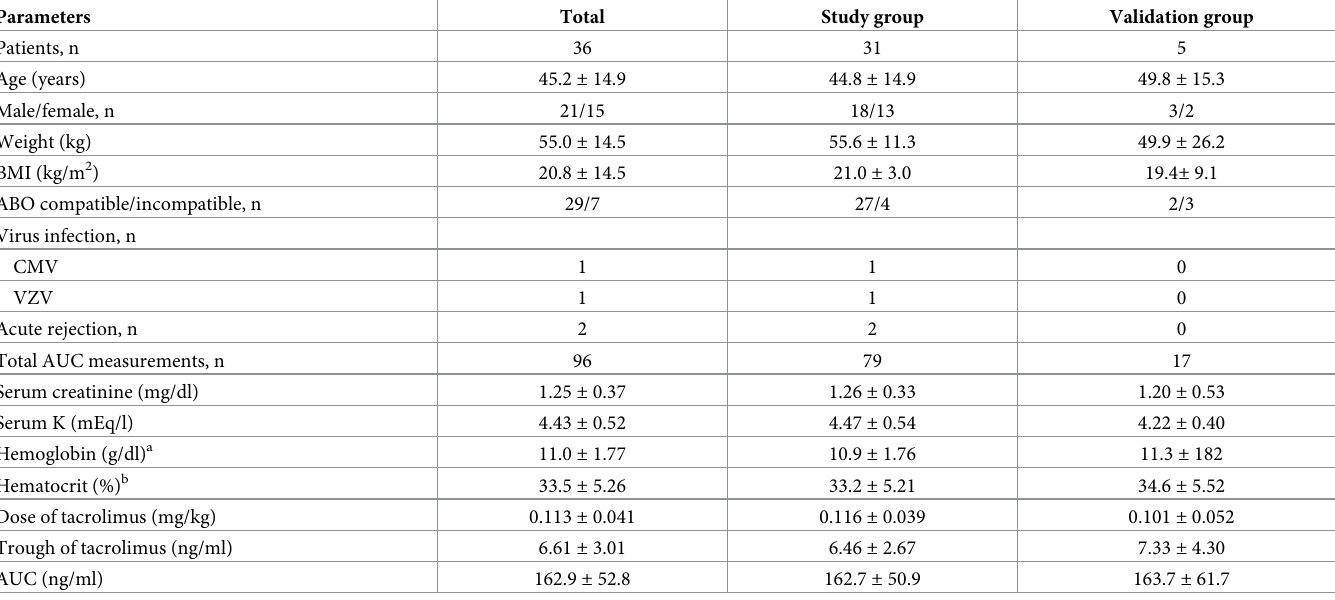
Table 1. Demographics and characteristics of the patients in this